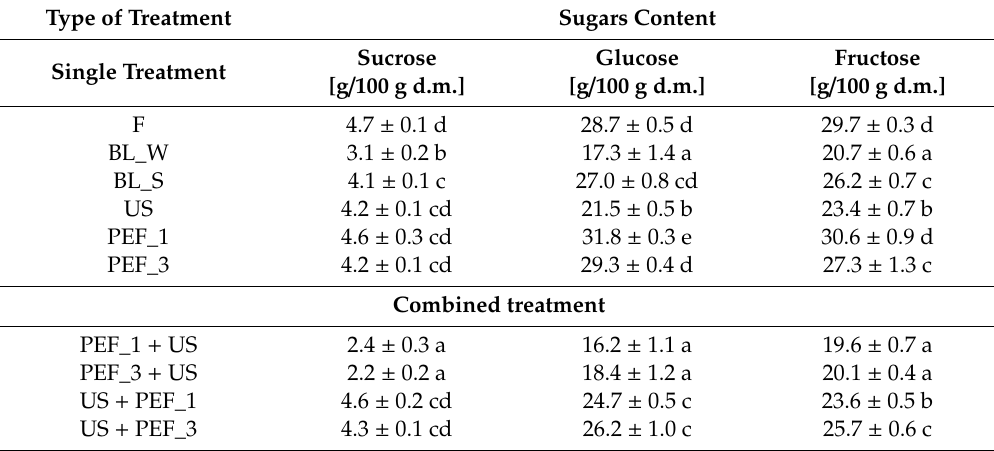
Table 1. Sugars content in fresh (F) red bell peppers and subjected to traditional (blanching in water BL_W and blanching in steam BL_S) and non-thermal single treatment (US–ultrasound, PEF_1 and PEF_3–pulsed electric field with energy input 1 and 3 kJ / kg, respectively) and combined treatment (PEF + US and US + PEF), error bars indicate ± SD (standard deviation calculated from 2 repetitions). Type of Treatment Sugars Content Sucrose Glucose Single Treatment [g / 100 g d.m.] [g / 100 g